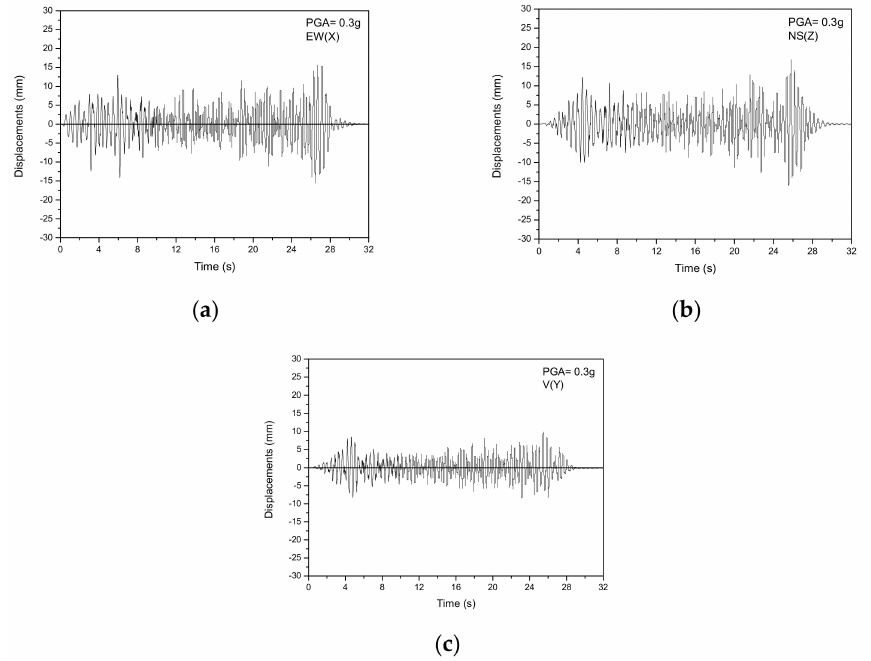
Figure 15. Displacement input motions used for analyses for PGA = 0.3 g: ( a ) EW (X); ( b ) NS (Z); ( c ) V (Y).